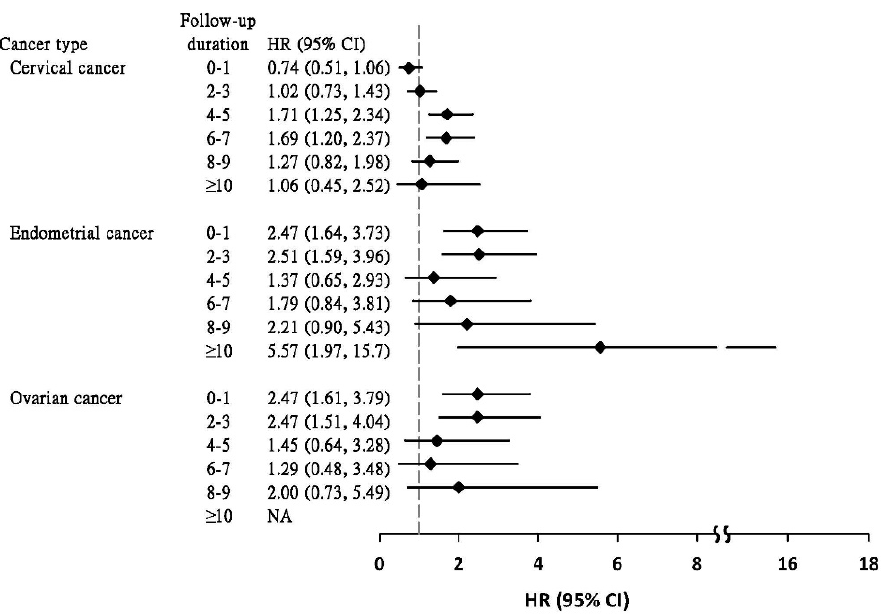
Figure 1. Cox proportional hazards regression analysis estimated adjusted hazard ratio of colorectal cancer for patients with gynecologic cancers compared to reference cohort by follow-up year.